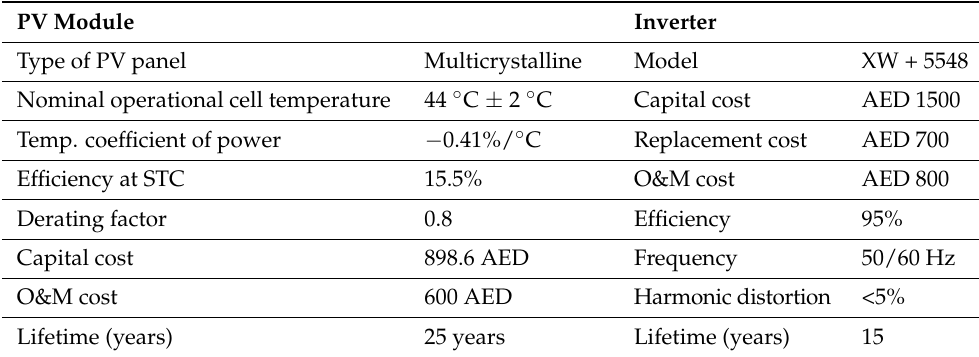
Table 10. Technical and Economical Details of PV Module and Inverter [34].